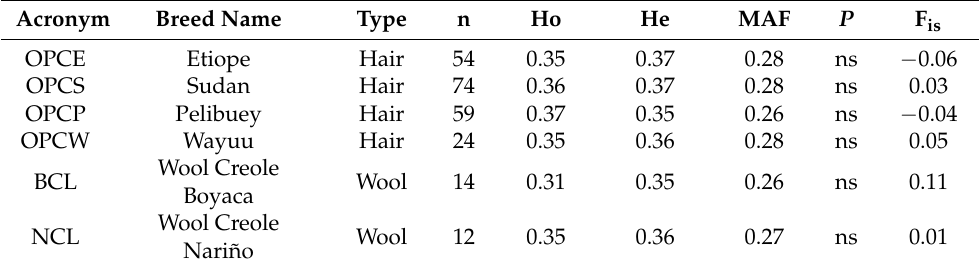
Table 2. Diversity indices in the six Colombian sheep breeds.